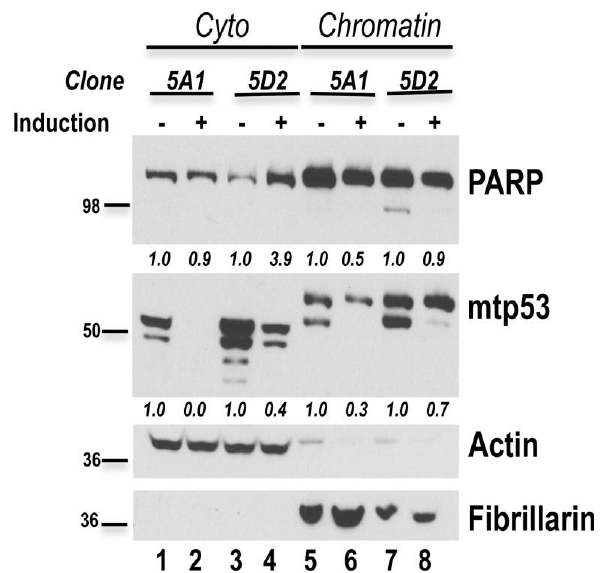
Figure 9. Depletion of mtp53 modulates PARP expression. HCC70. shp53 clones 5A1 and 5D2 were grown in the presence or absence of 6 μg/mL of doxycycline for 7 days and fractionation was carried out. Samples were resolved on a gradient 4%–12% SDS/PAGE which resulted in the observation of differentially migrating p53 in cytoplasmic and chromatin fractions [14]. A total of 50 μg of protein from the cytoplasmic fraction and 10 μg of the chromatin fraction per lane were resolved. Protein levels of p53, PARP1, actin, and fibrillarin in the fractions were determined by western blot analysis and the results were quantified by ImageJ. Actin was used to normalize the cytoplasmic fractions and fibrillarin was used to normalize the chromatin fraction (relative expression values comparing with and without knockdown are shown under the PARP1 and mtp53 western blots).